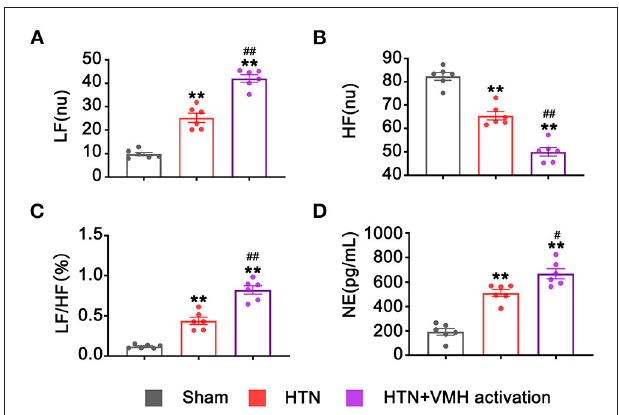
FIGURE 4 | VMH activation increased sympathetic nervous system activity. (A–C) Spectral analysis of heart rate variability: LF, HF, and the ratio of LF/HF; (D) NE levels in serum. Values are presented as mean ± SEM ( n = 6 per group). LF, low frequency (0.20–0.75Hz); HF, high frequency (0.75–2.5Hz); LF/HF, the LF/HF ratio; NE, norepinephrine. ** p < 0.01; vs. sham group; # p < 0.05, ## p < 0.01 vs. HTN